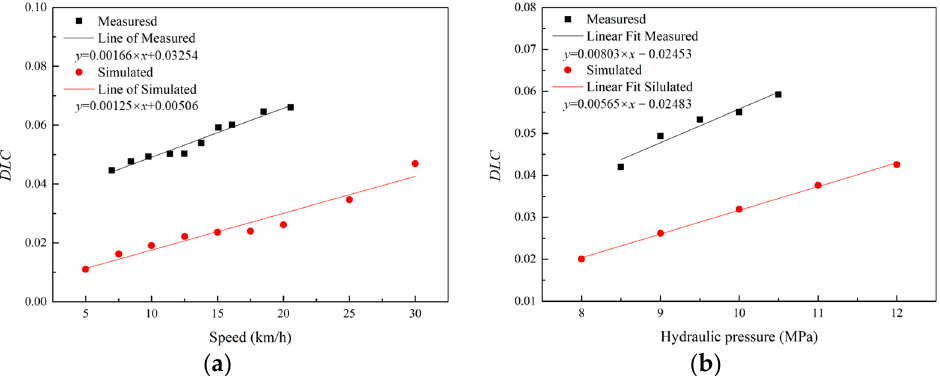
shown in Figure 11.